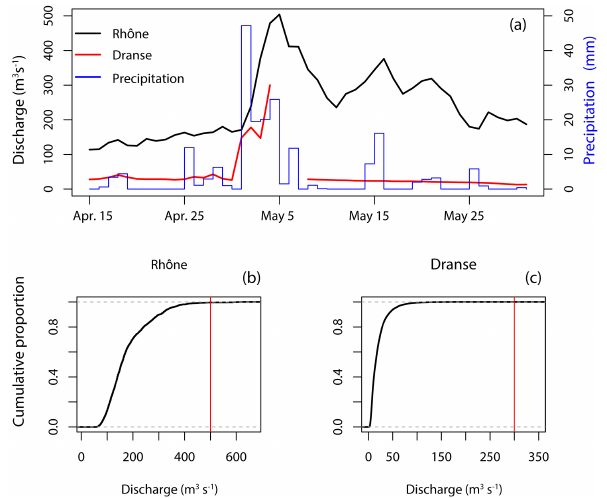
Figure 1. Hydrological characteristics of the flooding event of May 2015. (a) Daily precipitation and discharges of the two dominant tributaries of Lake Geneva, the Rhône and the Dranse rivers, over the months preceding and following the flood. The break in the dis- charge record of the Dranse corresponds to the date at which the station collapsed. Cumulative distribution of the Rhône discharges in 1976–2009 (b) and Dranse discharges 1957–2014 (c) . Red lines indicate the maximum discharges of the May 2015 event.